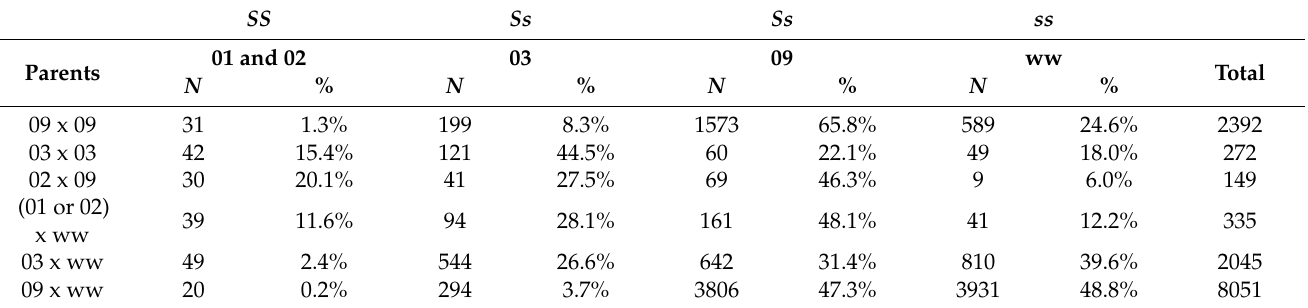
Table 2. Distribution of the offspring from selected crosses in PawPeds database according to proposed genotypes ( N = 13,244).